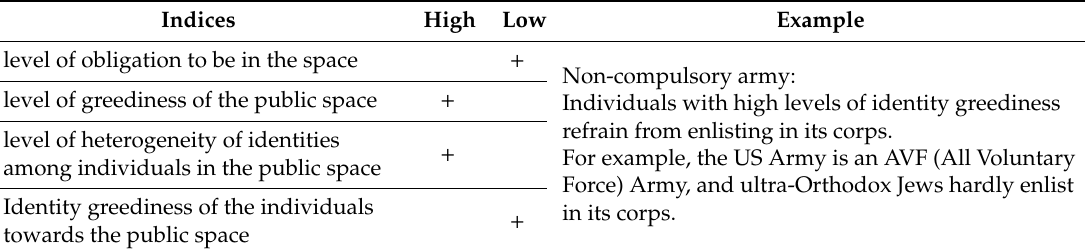
Table A13. Medium potential